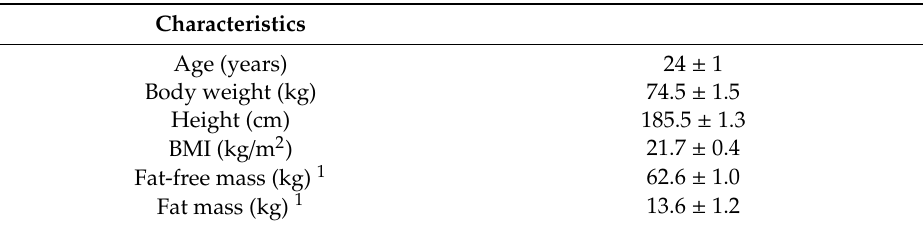
Table 2. Subject characteristics of completers at